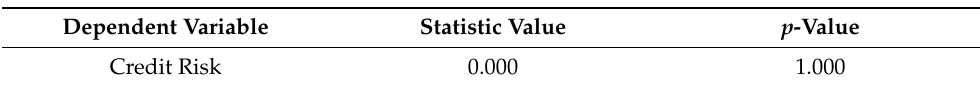
Table 7. Results of Hausman